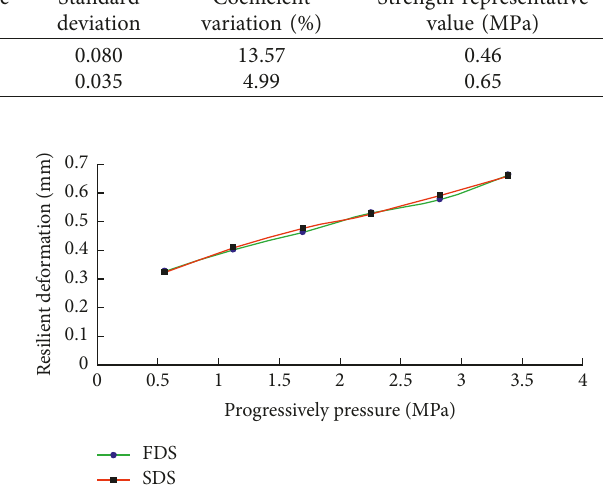
Figure 16: The relation curve between progressively pressure and resilient deformation. Table 12: The results of freezing-thawing